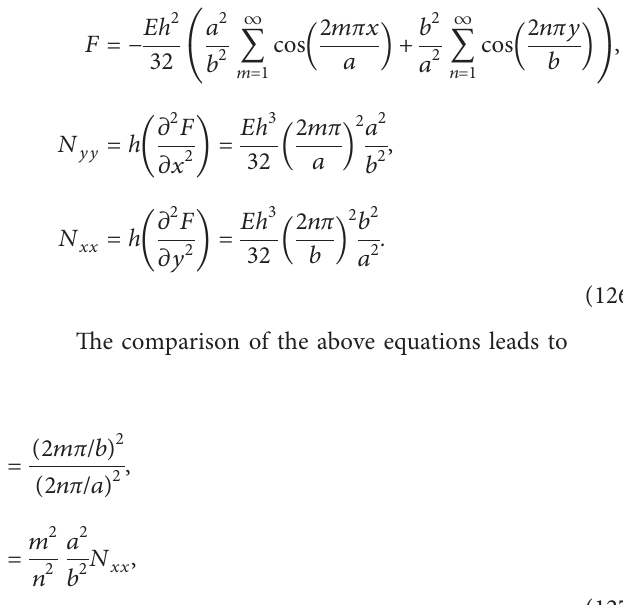
Figure 5: Variation of the membrane stiffness coefficient ( K plates with different edge